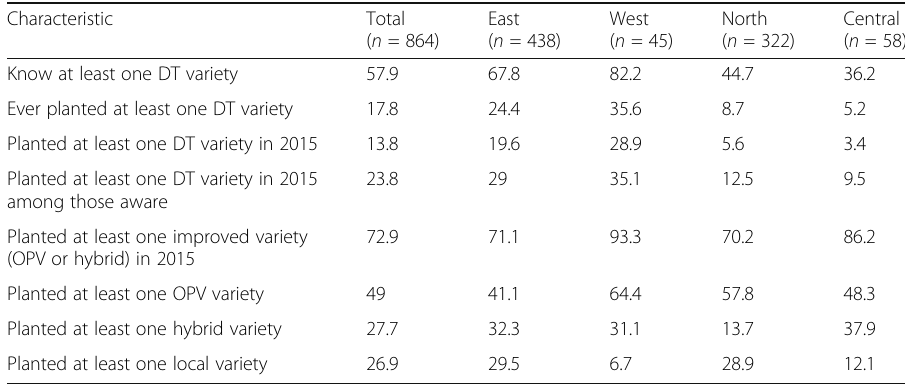
Table 2 Diffusion and adoption of